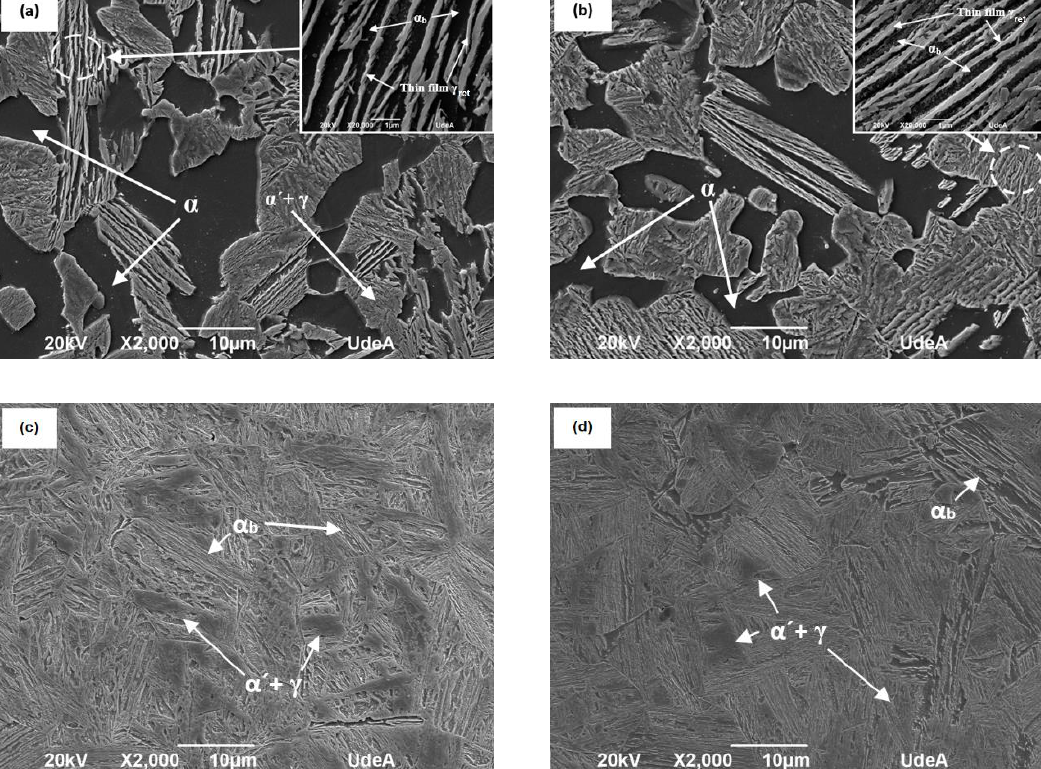
Figure 7. Secondary electron SEM images of the microstructure of the alloy with 0.29% of C, after austenitization at 830 °C, and treated isothermally at ( a ) 250 °C/480 min., and ( b ) 300 °C/240 min. and austenitization at 900 °C, and treated isothermally at ( c ) 250 °C/480 min., and ( d ) 300 °C/240 min. Where α is ferrite, α (cid:48) + γ is martensite + austenite and α b is bainitic ferrite.